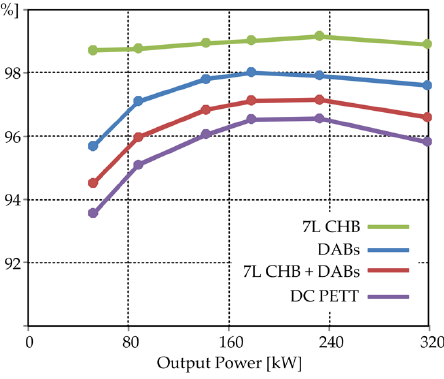
Figure 22. Measured efficiency versus output power of the three power stages and the entire 3kV DC PETT prototype.